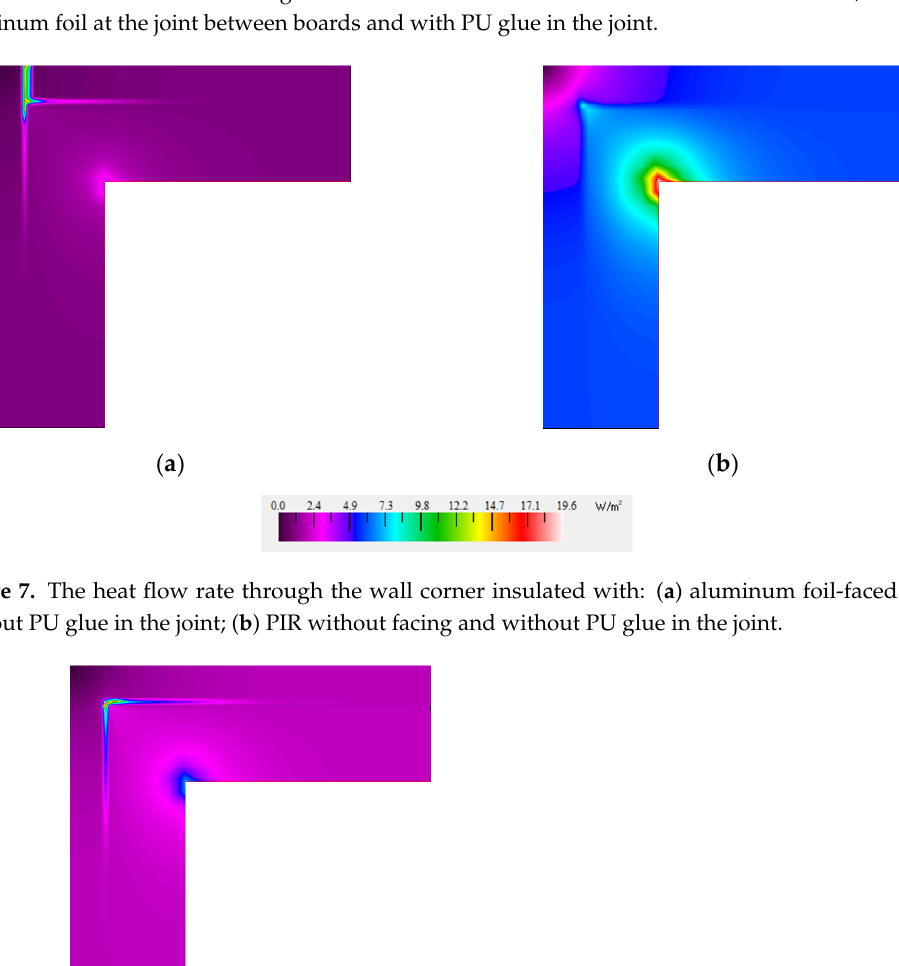
Figure 8. The heat flow rate through the wall corner insulated with aluminum foil-faced PIR, with removed aluminum foil and without PU glue in the joint. All results of the numerical simulations are summarized in Table 2.